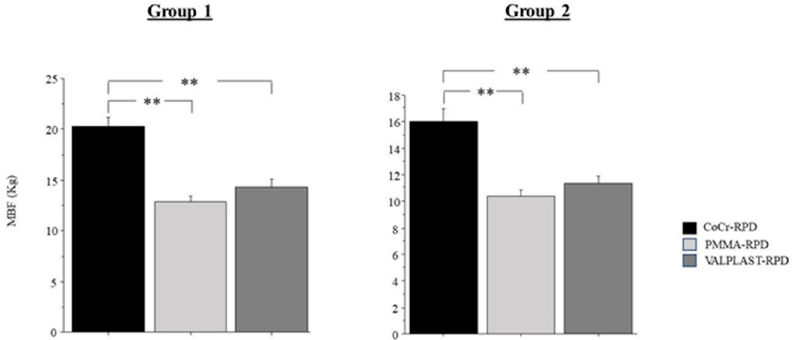
Figure 3. Maximal bite force in the three types of prostheses. (MBF = Maximal Bite Force; V-RPD = Valplast Removable Partial Denture; CoCr-RPD = Cobalt-Chrome Removable Partial denture; PMMA-RPD = Polymethyl Methacrylate Removable Partial Denture. ** = p < 0.01).